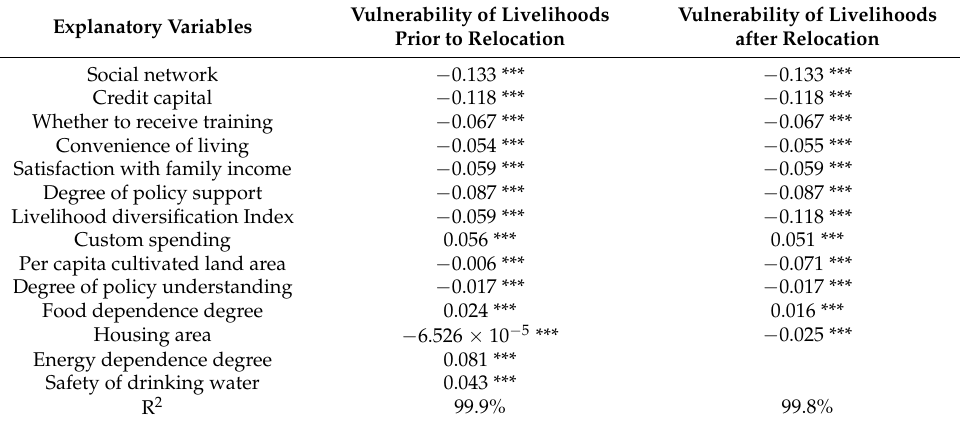
Table 6. Assessment results of influencing factors of livelihood vulnerability before and after house- hold relocation.